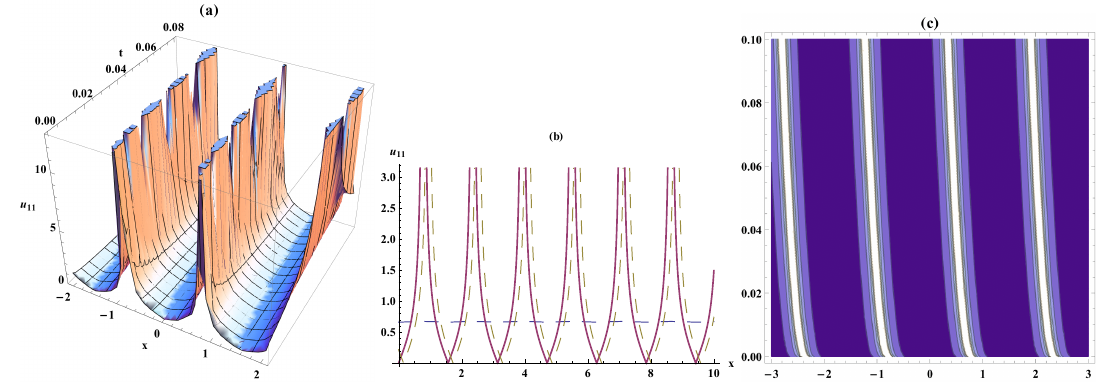
Figure 2. Periodic solitary wave, the bistable wave amplitude, and contour plots for Equation (11). On the respective interval { x , − 2.05,2.05 } , { t , − 0.08,0.08 } , { x , − 10,10 } , { t , − 1,1 } , { x , − 3,3 } , { t , − 0.1,0.1 } .